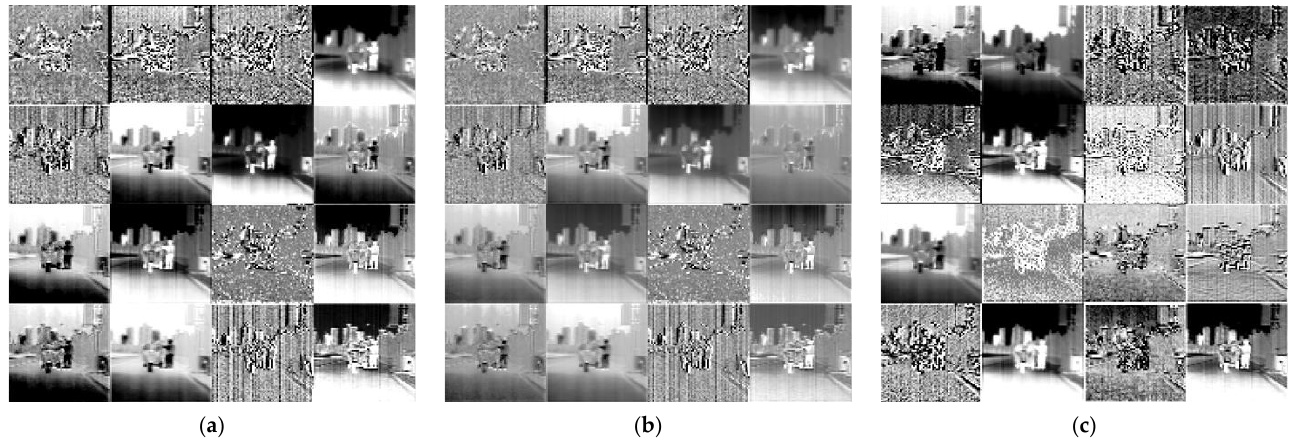
Figure 15. SEBlock feature layer visualization. ( a ) The characteristic layer of the input channel atten- tional mechanism module; ( b ) the output feature layer of SEBlock; ( c ) the output feature layer of the model without SEBlock.